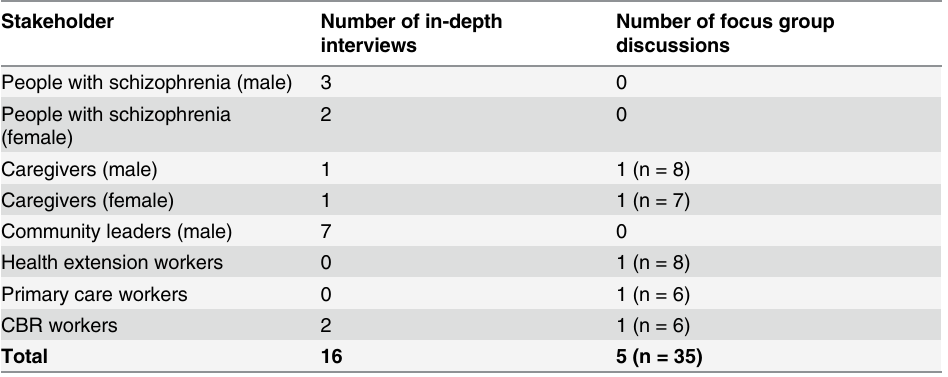
Table 1. In-depth interviews and focus group discussion